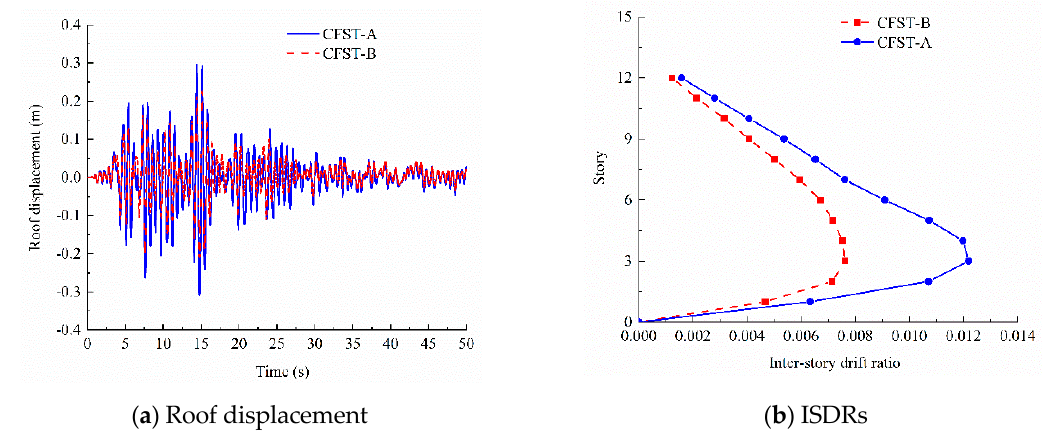
Figure 11. Comparison of the roof displacement and ISDRs between CFST-A and CFST-B (Taft PGA = 1.0 g).